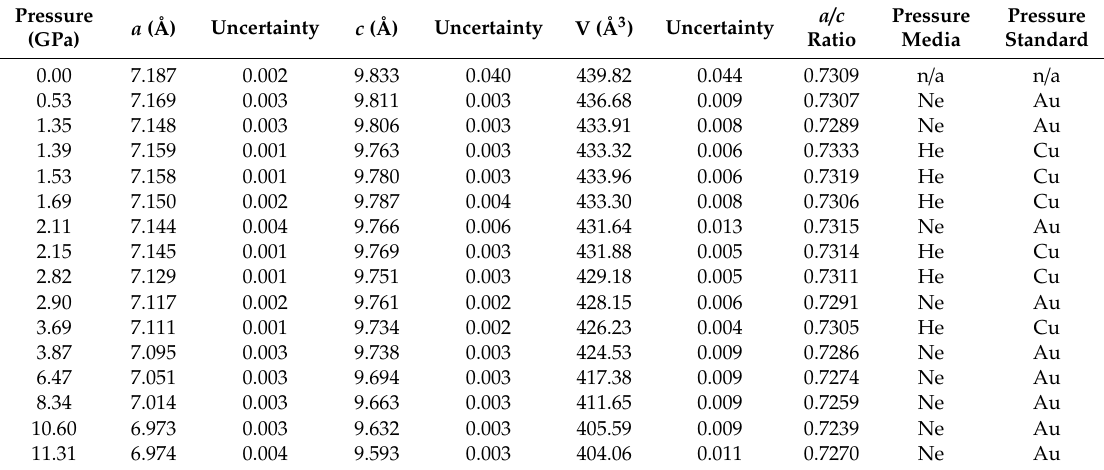
Table 4. Bastnäsite-(La) measured lattice parameters, unit cell volumes, a / c crystallographic axis ratios, pressure transmitting media, and pressure standards from 0 GPa to 11.3 GPa at ambient temperature.